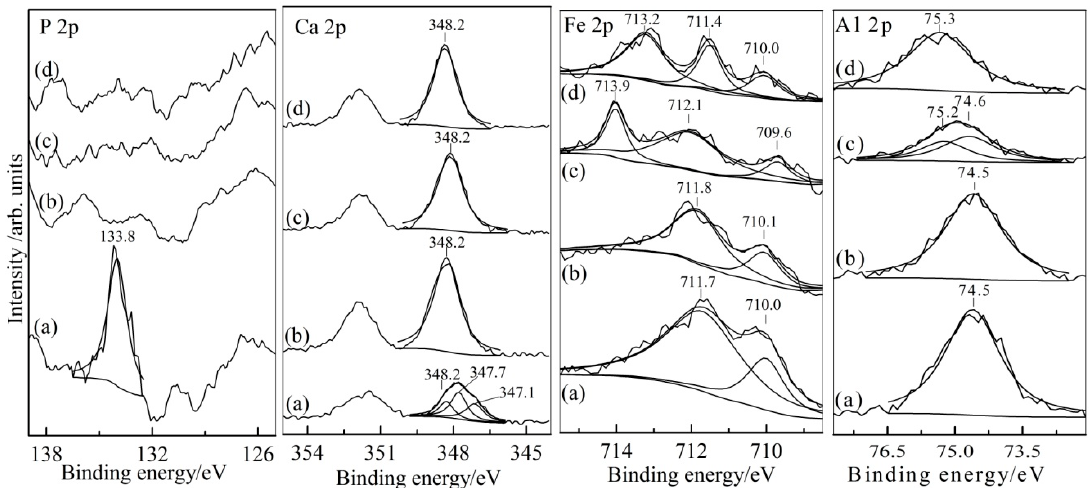
Figure 8. X-ray photoelectron P 2p, Ca 2p, Fe 2p and Al 2p spectra from roasted stone coal ( a ); dephosphorization sample ( b ); leaching residue (I) ( c ); and leaching residue (II) ( d ).